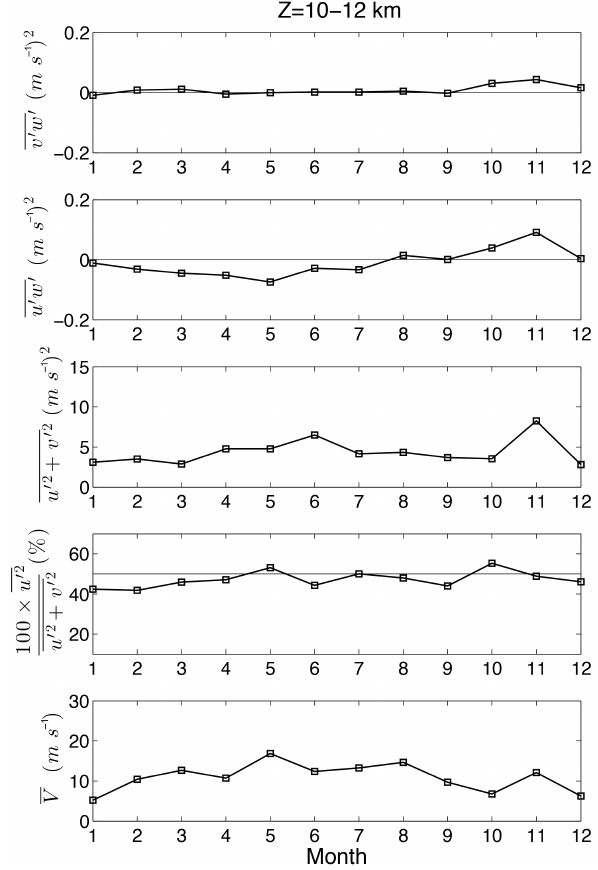
Figure 10. Monthly means of meridional v (cid:48) w (cid:48) and zonal u (cid:48) w (cid:48) com- ponents of the vertical momentum flux associated with IGWs, vari- ance of horizontal perturbation velocities of IGWs u (cid:48) 2 + v (cid:48) 2 and contribution of the zonal perturbation velocity to the variances . In the last panel mean background wind V between 10 and 12km is shown.